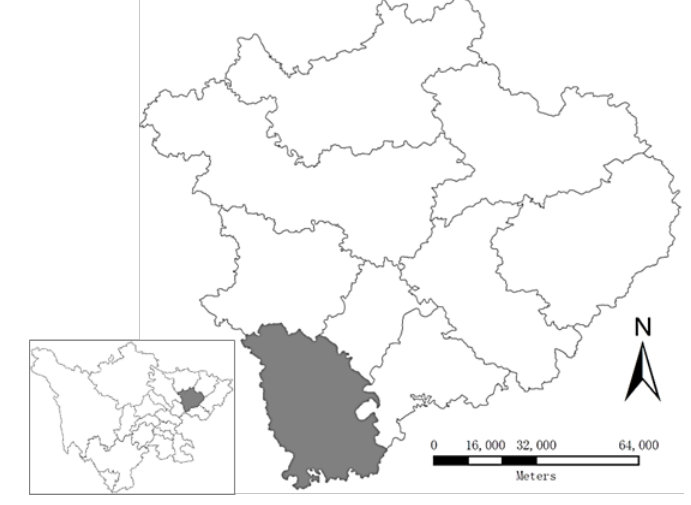
Figure 1. The location of Jialing district in Nanchong, Sichuan